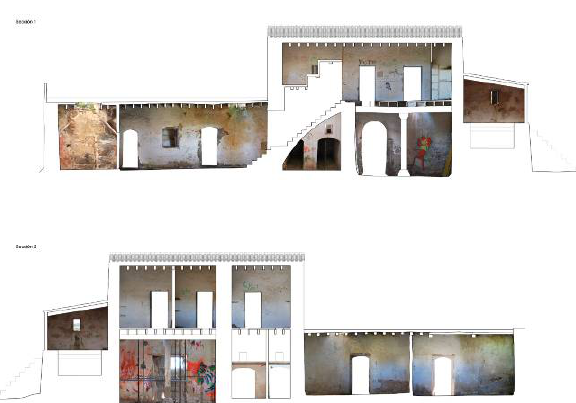
Fig. 3. Semi-manual survey. Sections of Can